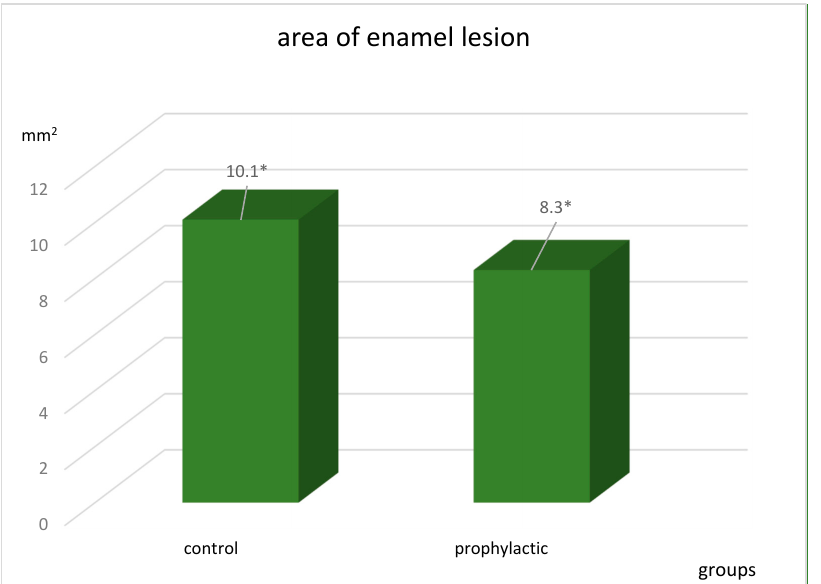
Figure 3. Area of enamel lesion in the staining stage in the control and prophylactic groups in mm 2 . * The results obtained are statistically significant: p < 0.0001